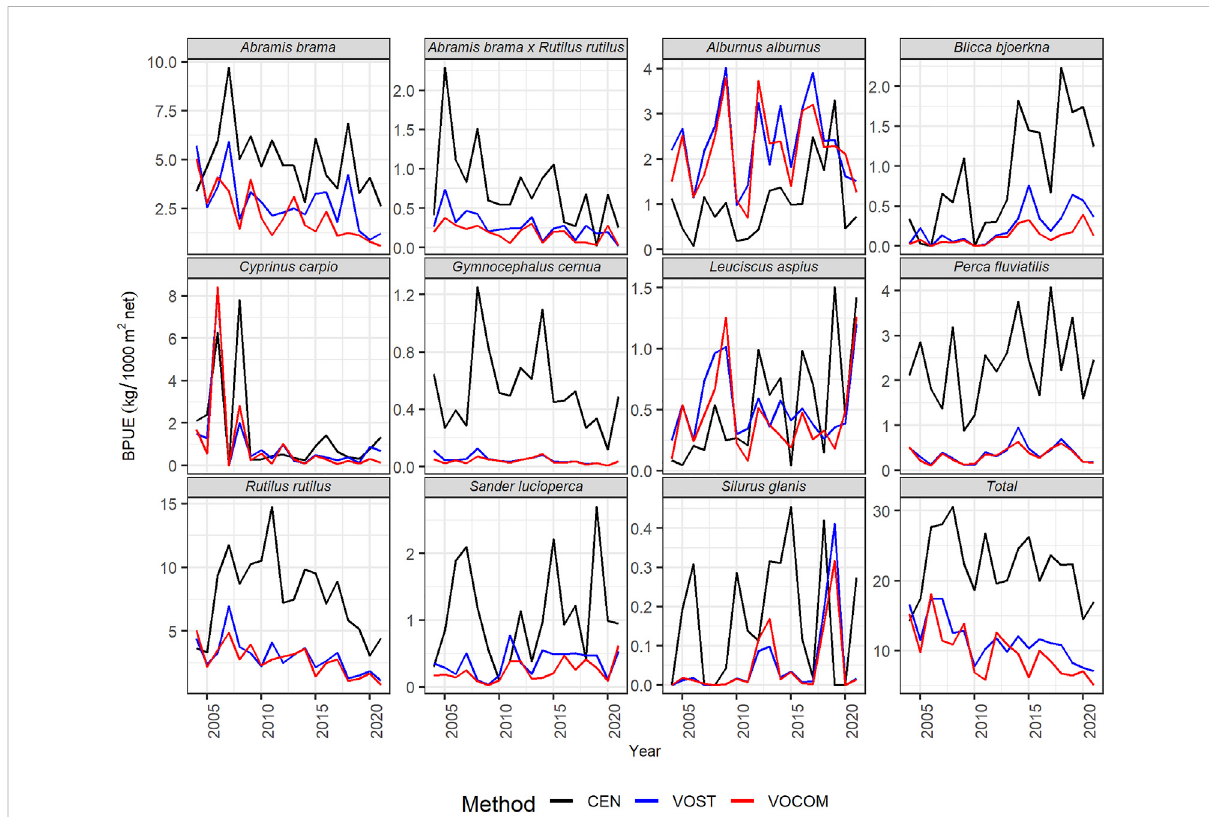
FIGURE 3 Estimated time-series whole-reservoir BPUEs ofthe dominant fi sh species and thewhole fi sh community(total)in the Ř ímov Reservoir derived from CEN, VOST, and VOCOM